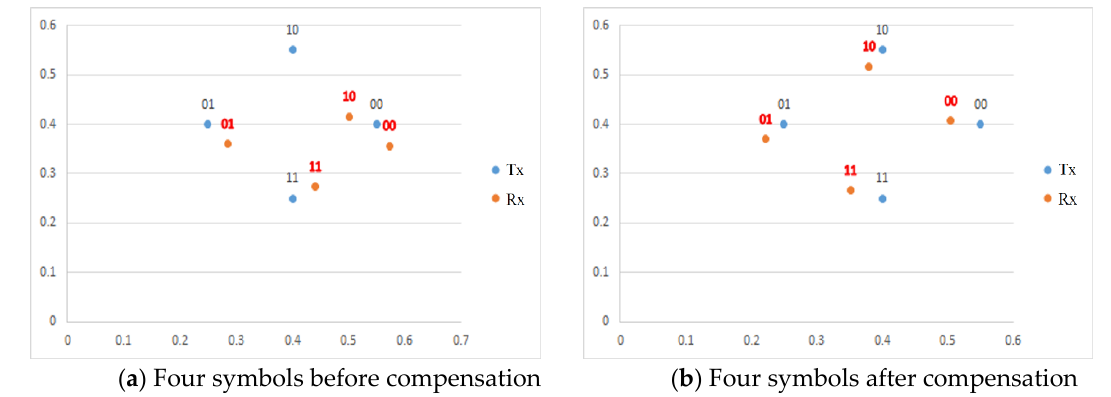
Figure 11. Compensation of channel noise by sending a reference color in the color space of CIE1931.